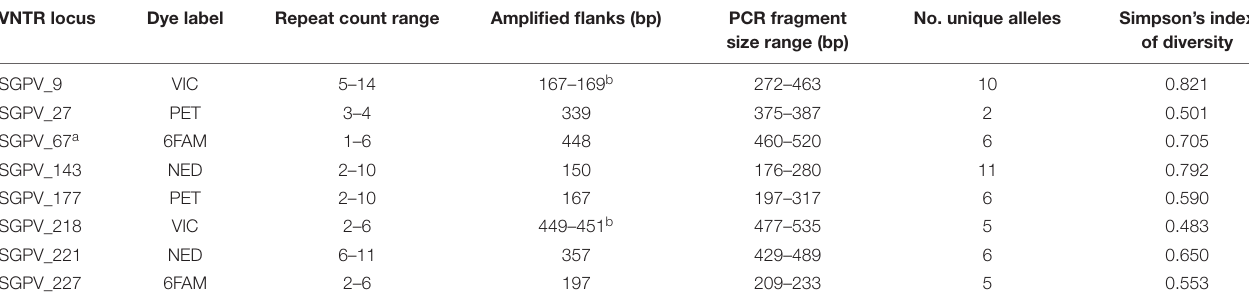
TABLE 2 | Metrics for each VNTR locus within the studied dataset, as inferred from MLVA typing. VNTR locus